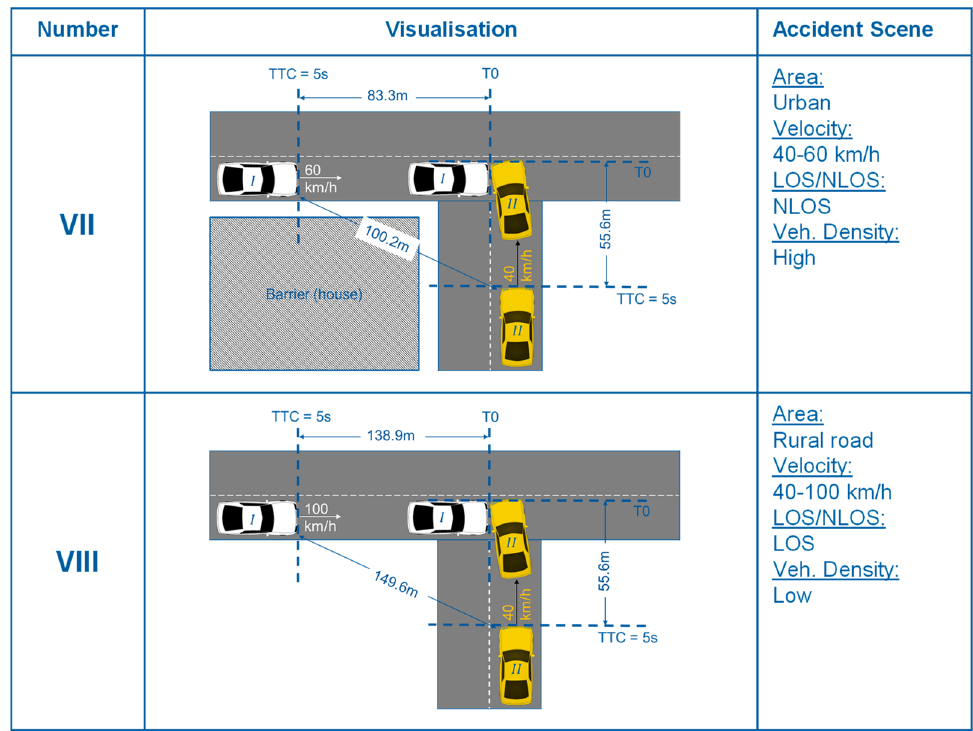
Figure 7. Illustration of the investigated “worst-case” turning crash scenarios (82 + 83).